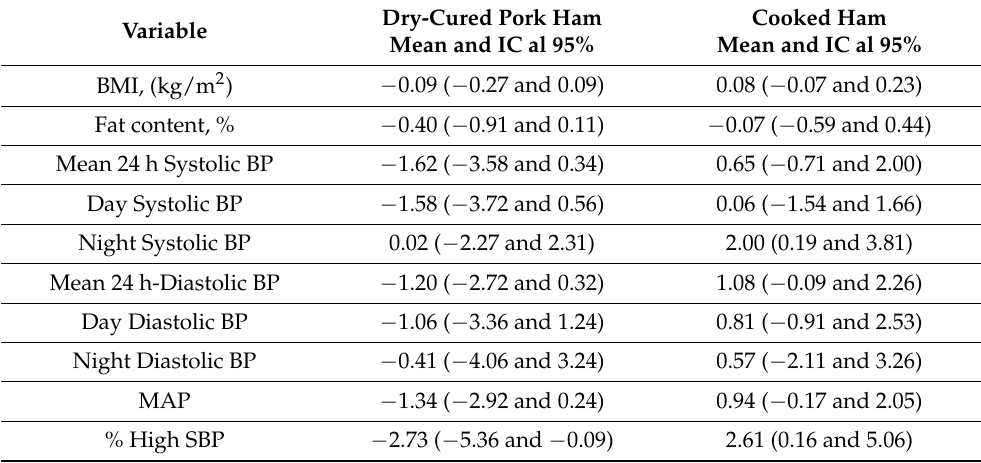
Table 1. Mean effect and 95% confidence interval after eating dry-cured ham and cooked